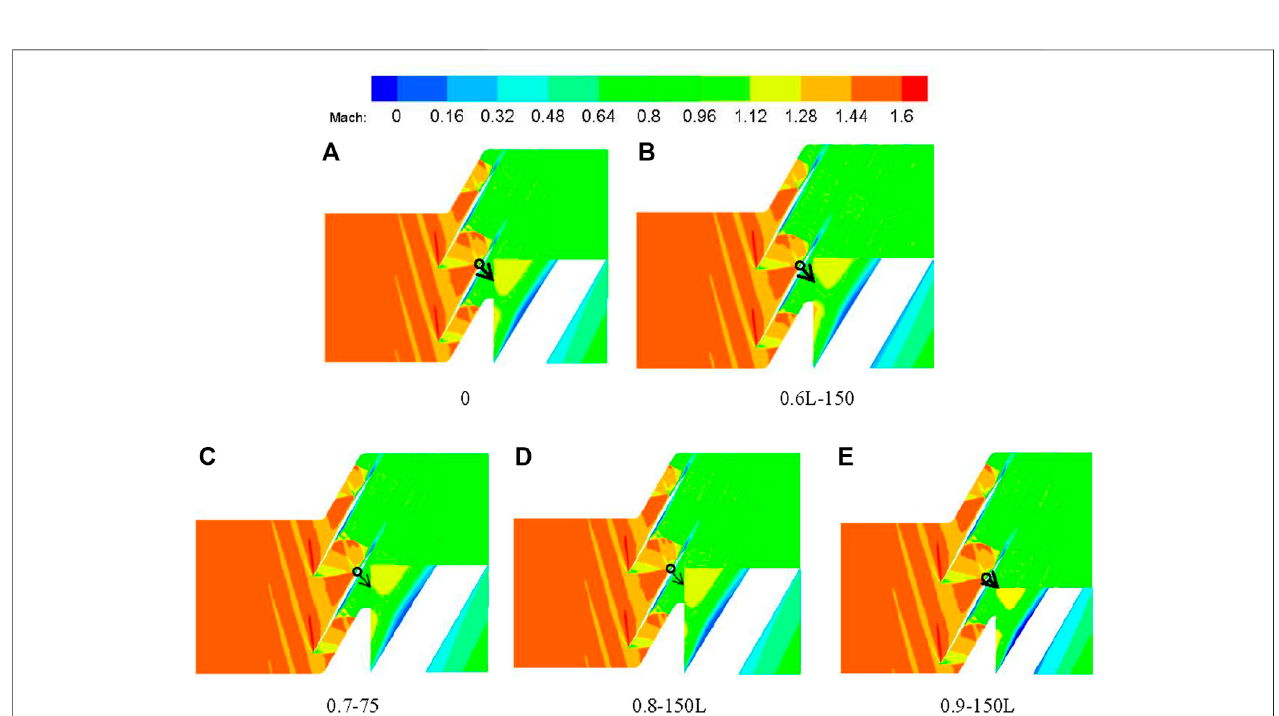
FIGURE 10 | Mach number contours of the supersonic cascade and Partially enlarged.